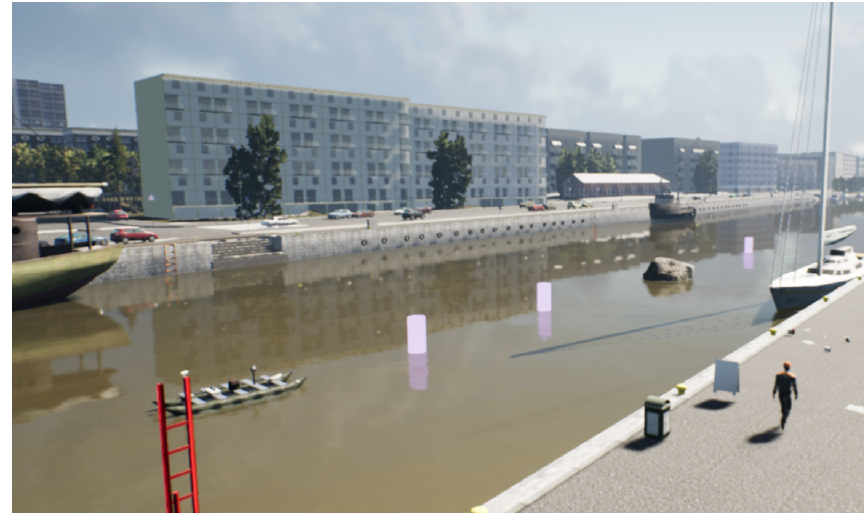
Figure 6. DRL model training setup in AILiveSim. The pink cylinders represent the global static waypoints while the rock is an obstacle amidst the planned trajectory. Note that the static waypoints are not recomputed when an obstacle is encountered.